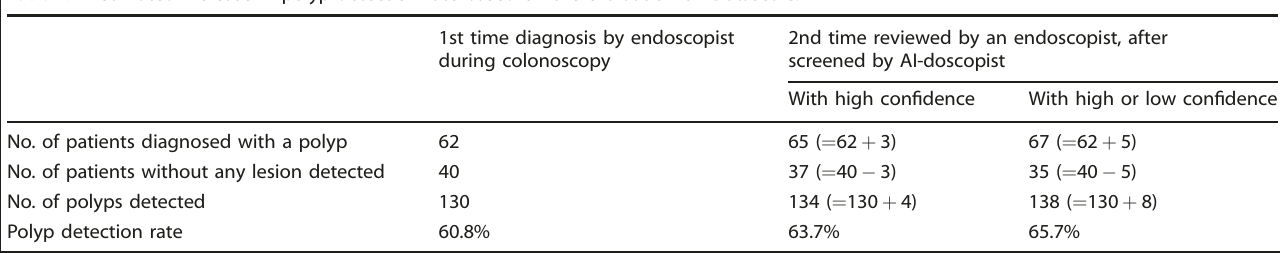
Table 2. Estimated increase in polyp detection rate based on the evaluation on Dataset